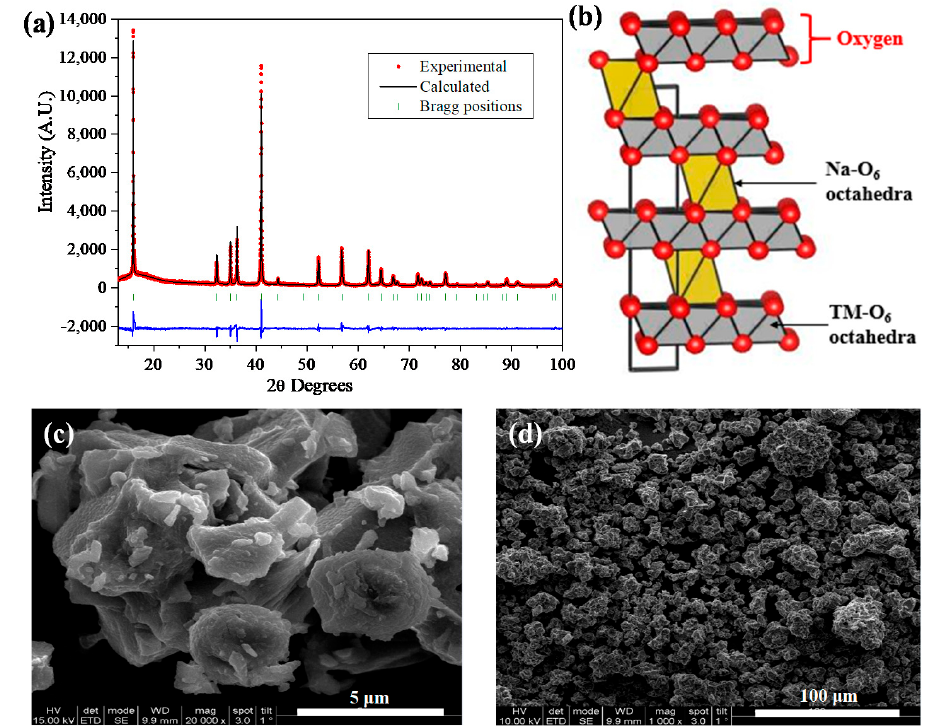
Figure 1. ( a ) Rietveld refinement plot and NFCTO HRPD patterns, ( b ) polyhedral representation of the O3 structure of Na 0.8 Fe 0.4 Co 0.4 Ti 0.2 O 2 : yellow octahedra represent sodium, while gray represents Fe/Co/Ti octahedra. SEM images of NFCTO at ( c ) higher and ( d ) lower magnifications.